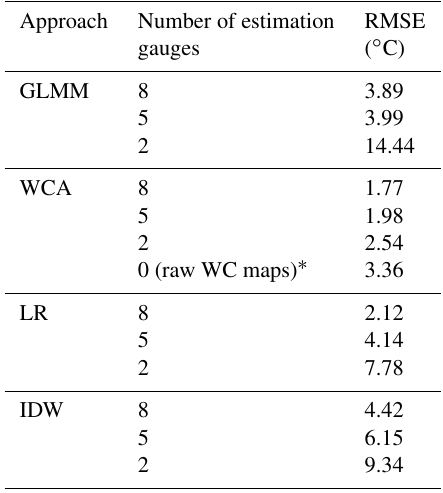
Table 4. Sensitivity test of the temperature interpolation ap-